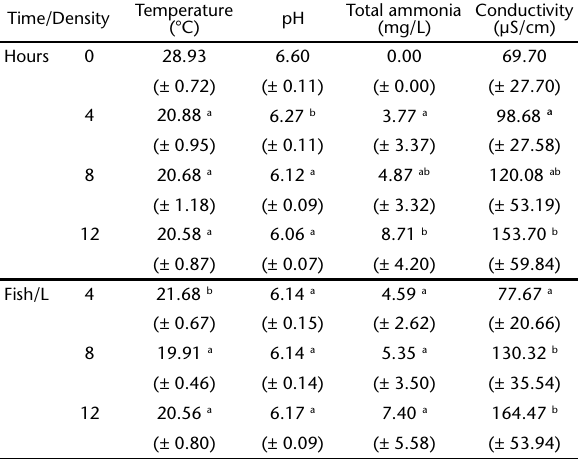
Table I. Temperature, pH, total ammonia and conductivity (mean ± standard deviation) at the beginning and after simulated transport of fingerlings of Pimelodus maculatus for 0, 4, 8, and 12 hours in densities 4 (22.88 g/L), 8 (45.76 g/L) and 12 (68.64 g/L) fish/L. Different letters indicate significant differences among groups in the same day by two-way ANOVA and Tukey test (p <